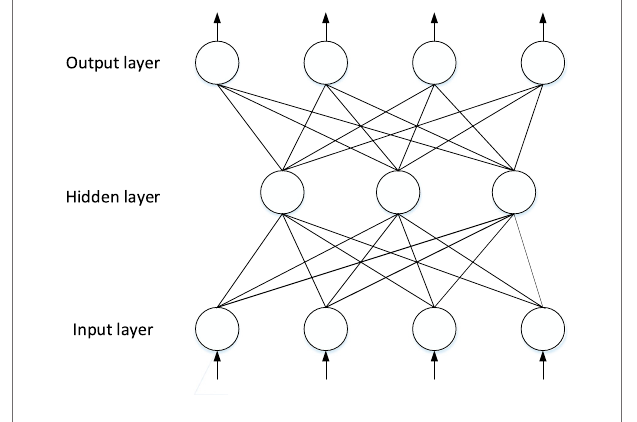
FIGURE 6 | Typical three-layer neural network.